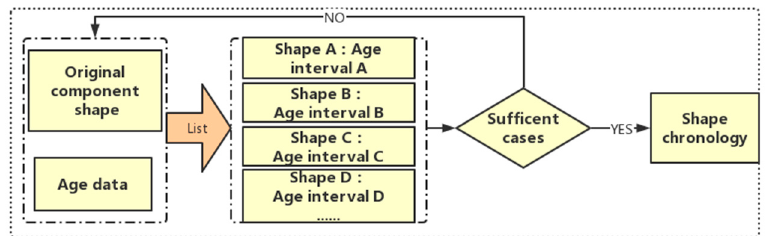
Figure 7. Compilation of shape